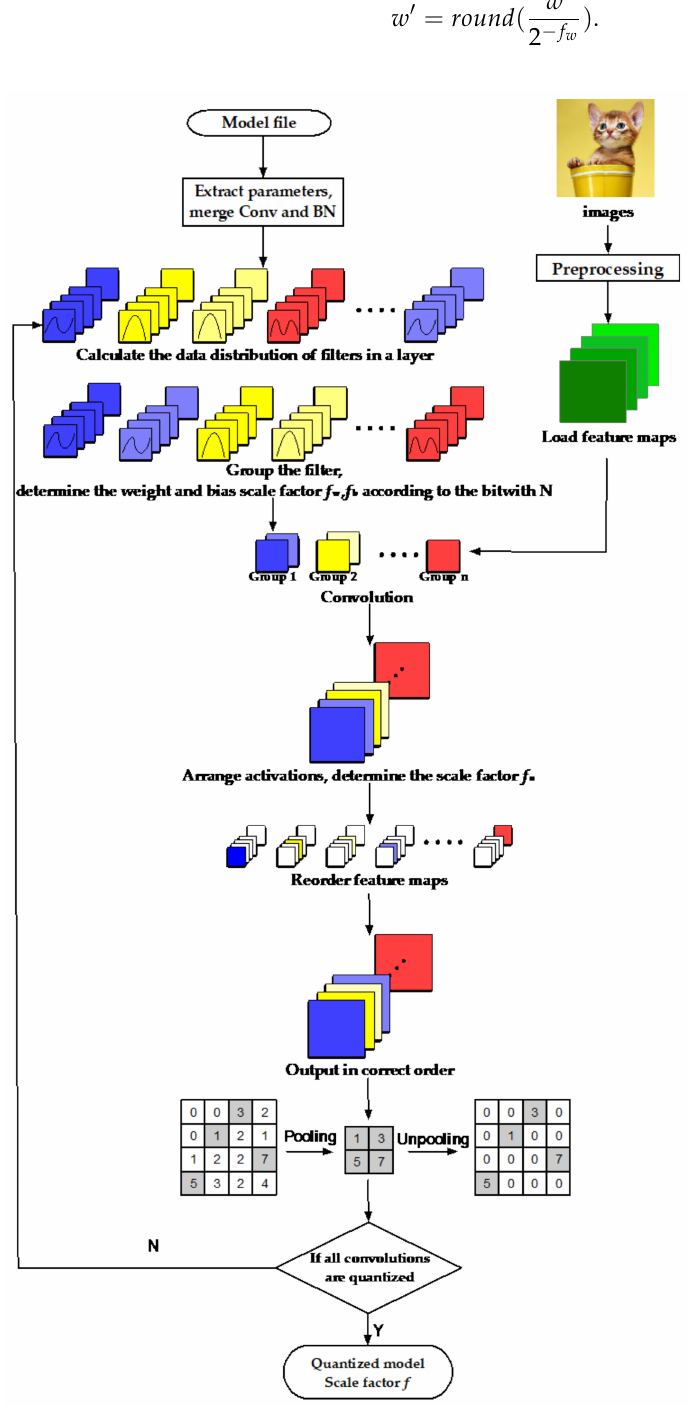
Figure 3. The process of